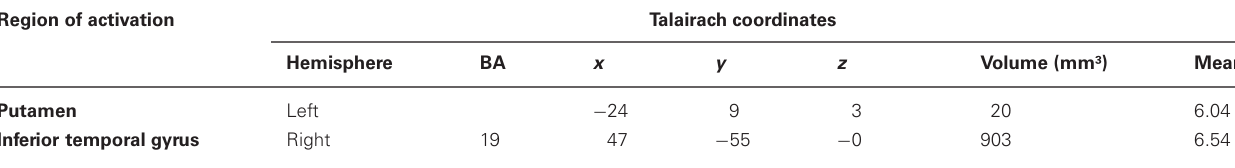
Table 1 | Brain areas with stronger BOLD signal after delayed compared to omitted feedback ( q = 0.05 ). Region of